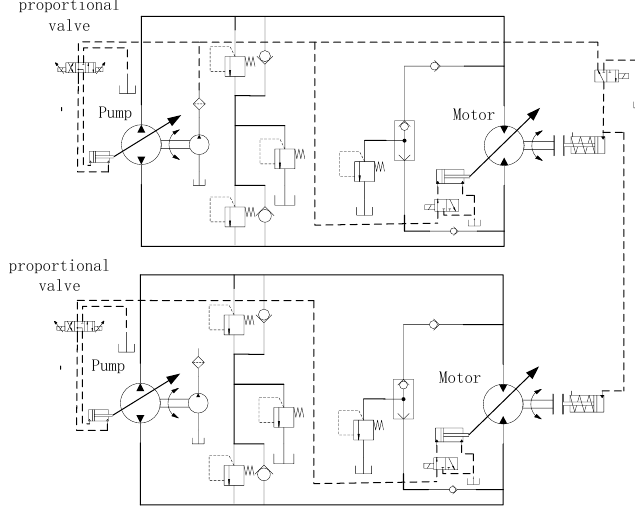
Figure 1. Hydraulic transmission schematic diagram of paver.